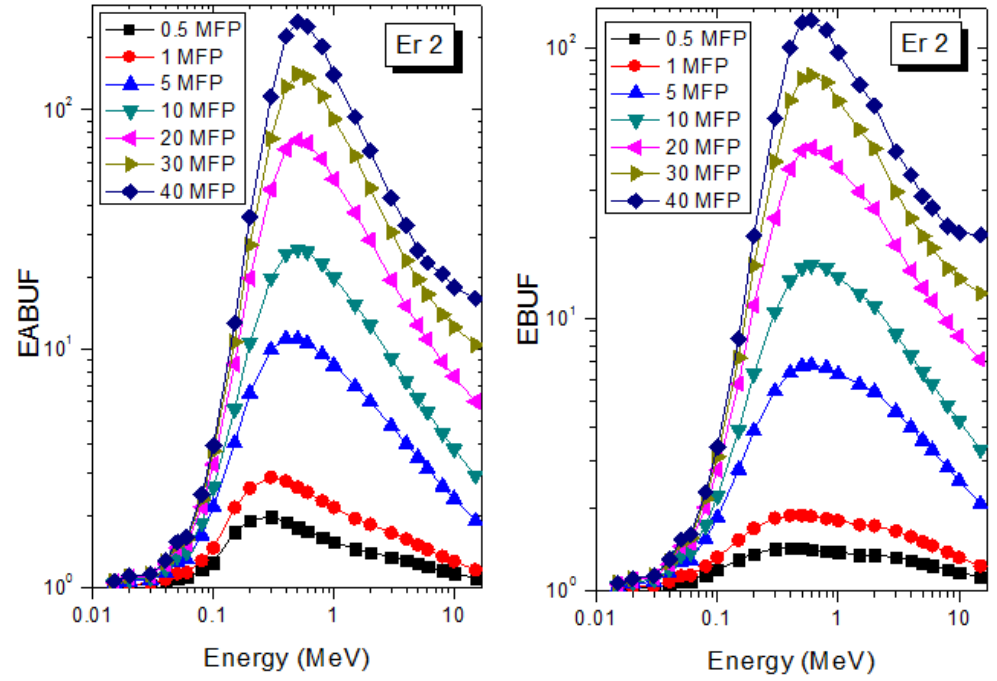
Figure 2. EABUF and EBUF variation with gamma-ray photon energy for Er 2.